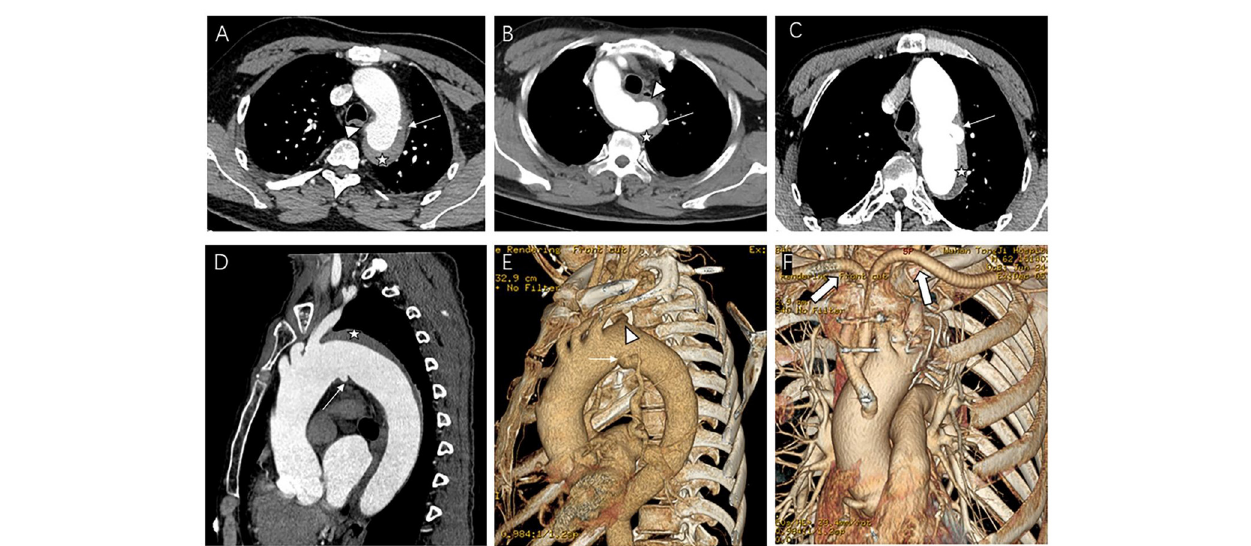
FIGURE 2 | Contrast-enhanced CT angiography (CTA) image of the aberrant subclavian artery patients with aortic intramural hematoma (IMH) and penetrating atherosclerotic ulcer (PAU) or ulcer-like projection (ULP). (A) Patient with PAU (arrow) located near the aberrant right subclavian artery (ARSA) ostium (arrowhead) and IMH (star); (B) Patient with aberrant light subclavian artery and IMH (star), the PAU (arrow) located on the Kommerell’s diverticulum (KD) (arrowhead). (C–F) Patient with ULP (thin arrow) located near the ARSA ostium (arrowhead) and IMH (star) underwent hybrid repair, thick arrow showing the artificial blood vessel from ascending aorta to subclavian arteries.